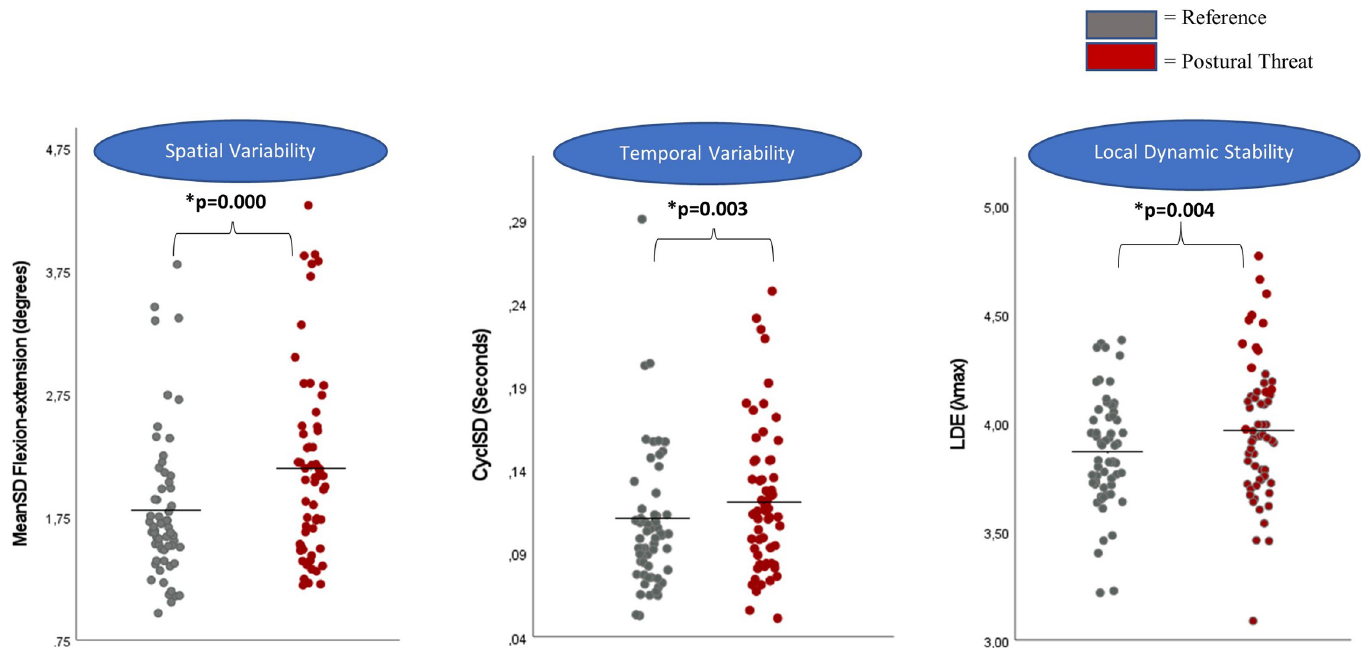
Fig 3. Within-subject effect: Lumbar movement characteristics during repetitive seated reaching (40x) in the reference-trial and in a context of postural threat. Dots represent individual participants, horizontal lines represent the group mean.